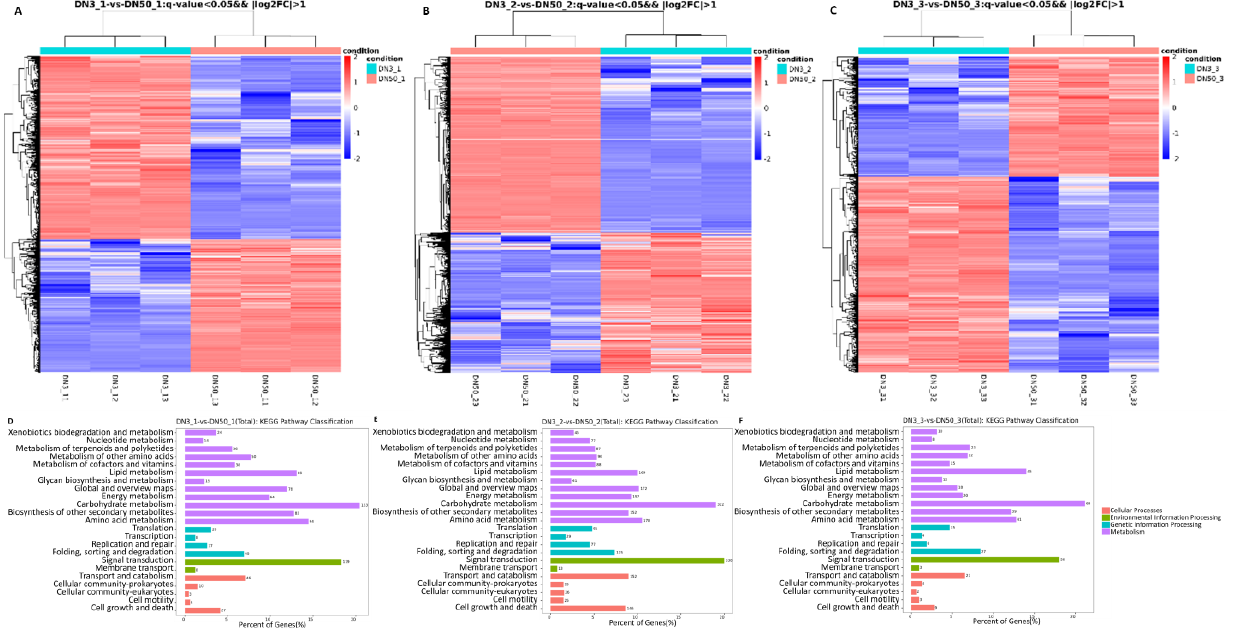
Figure 6. Differential gene expression transcriptome analysis. ( A – C ) Hierarchical cluster analysis of differential gene expression between 3-1 and DN50 at 21DAF, 28DAF, and 42DAF, respectively. Gene expression levels are shown using different colors, where blue represents a low expression level and red represents a high expression level. ( D – F ) KEGG pathway classification of differentially expressed genes between 3-1 and DN50 at 21DAF, 28DAF, and 42DAF, respectively.